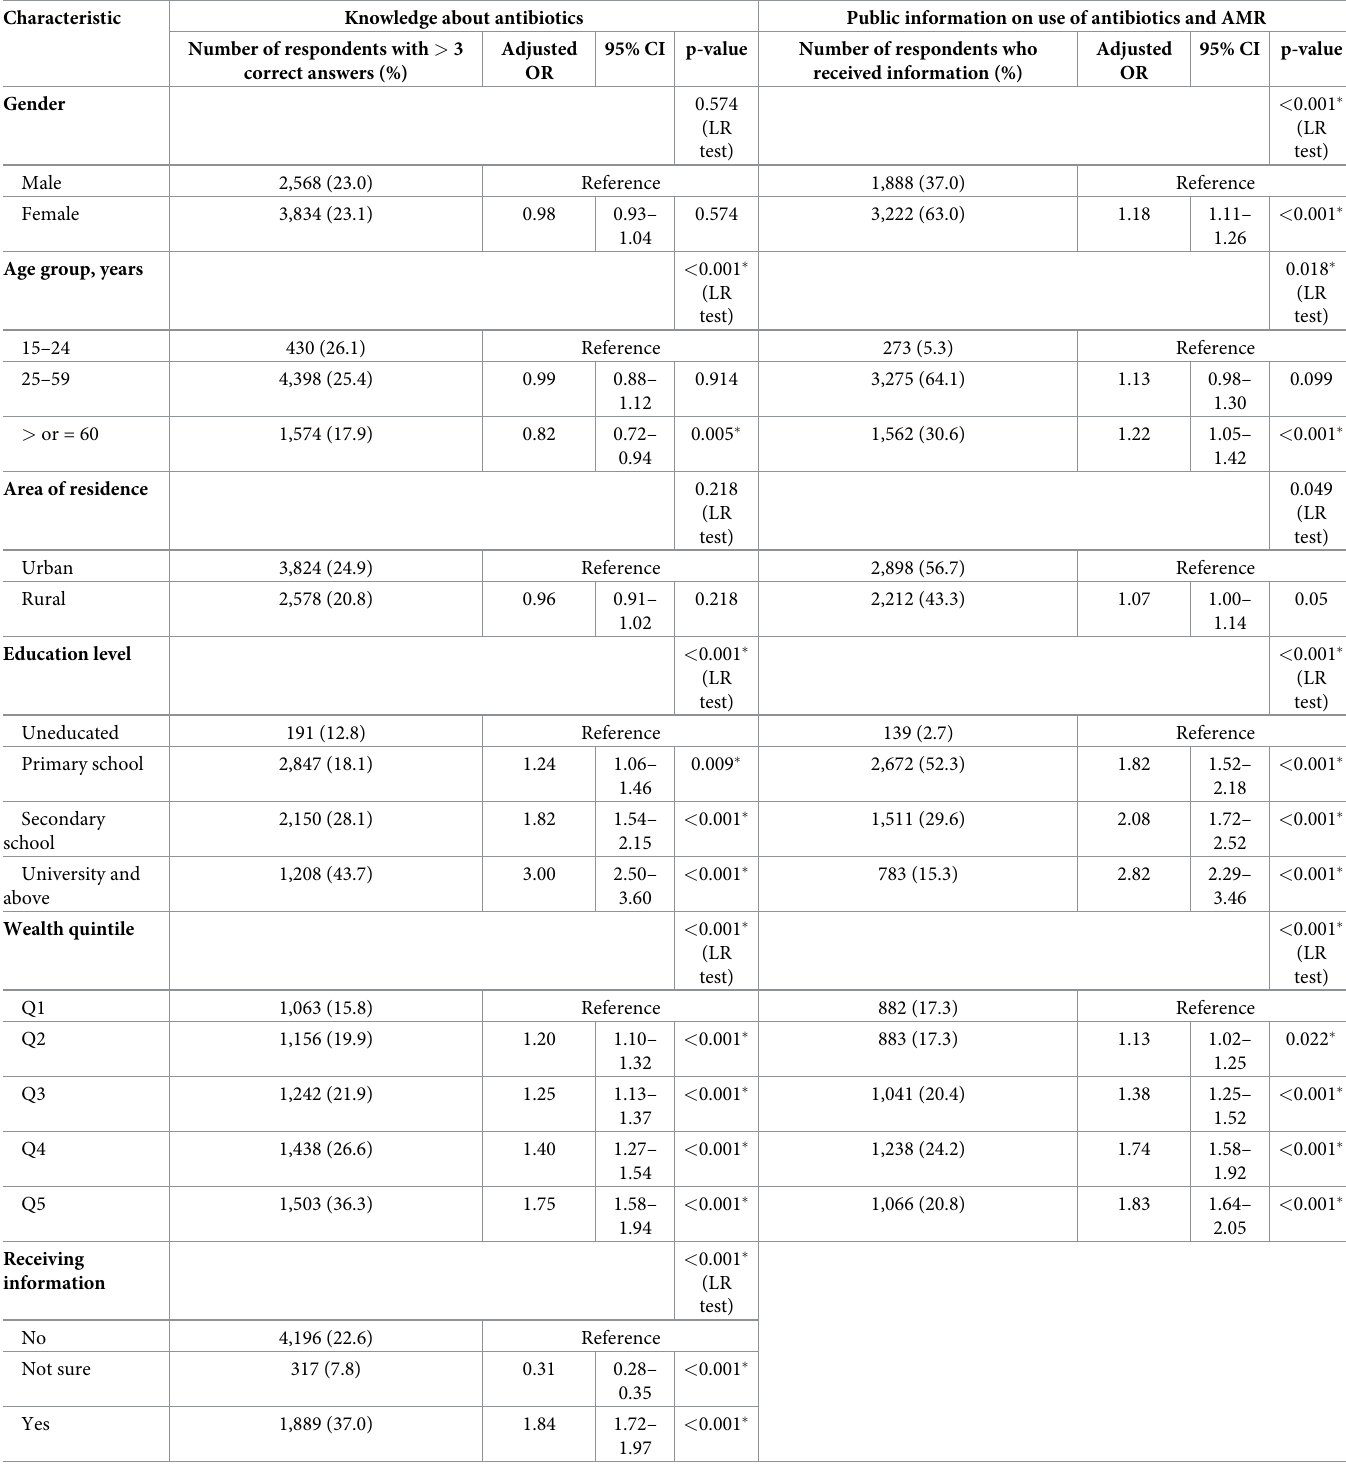
Table 2. Multivariate analysis of demographical factors associated with high level of knowledge and receiving information about antibiotic use and